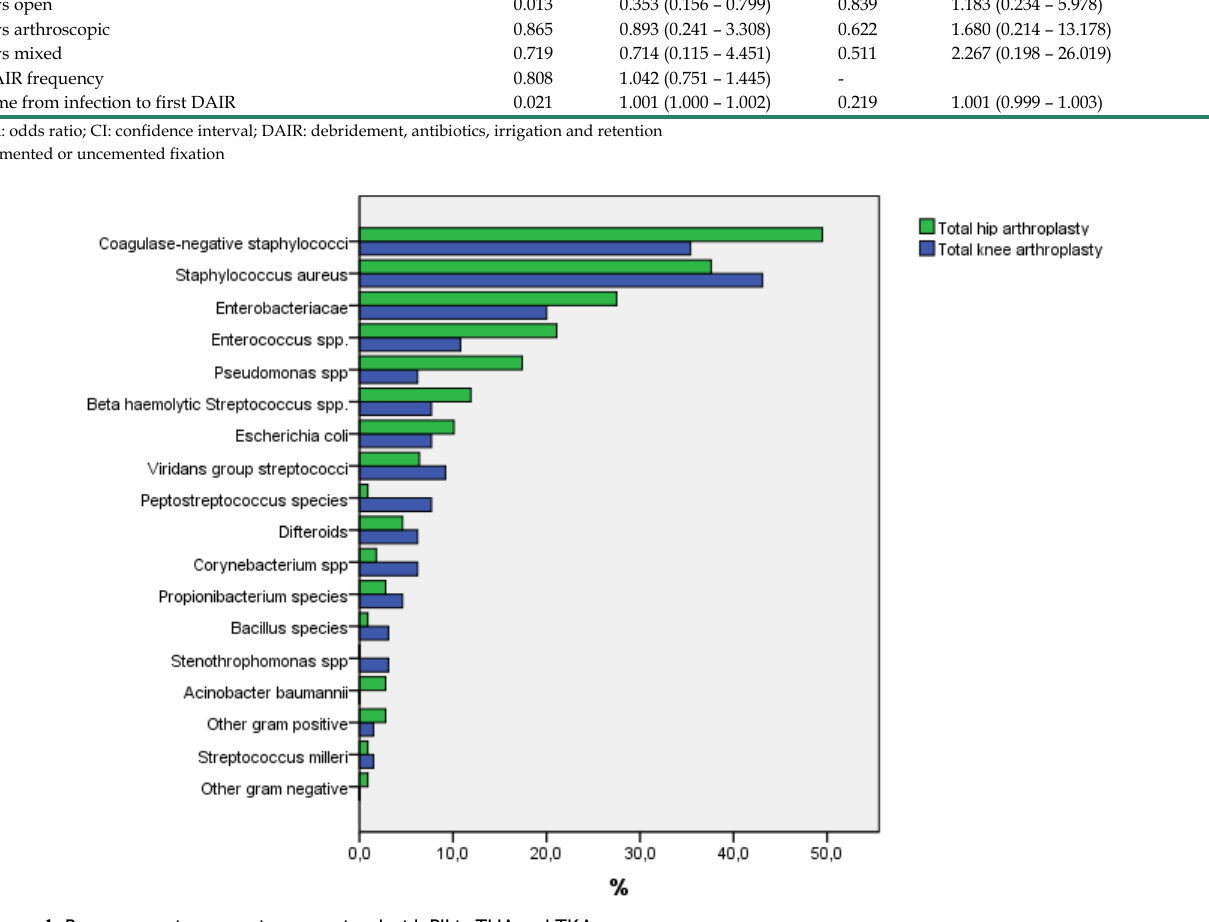
Figure 1. Percentage micro organisms associated with PJI in THA and